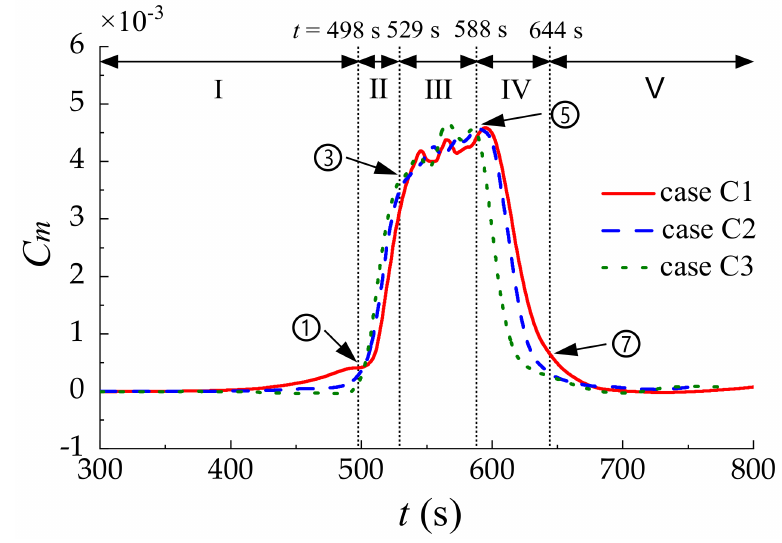
Figure 18. Time series of torque with different navigating